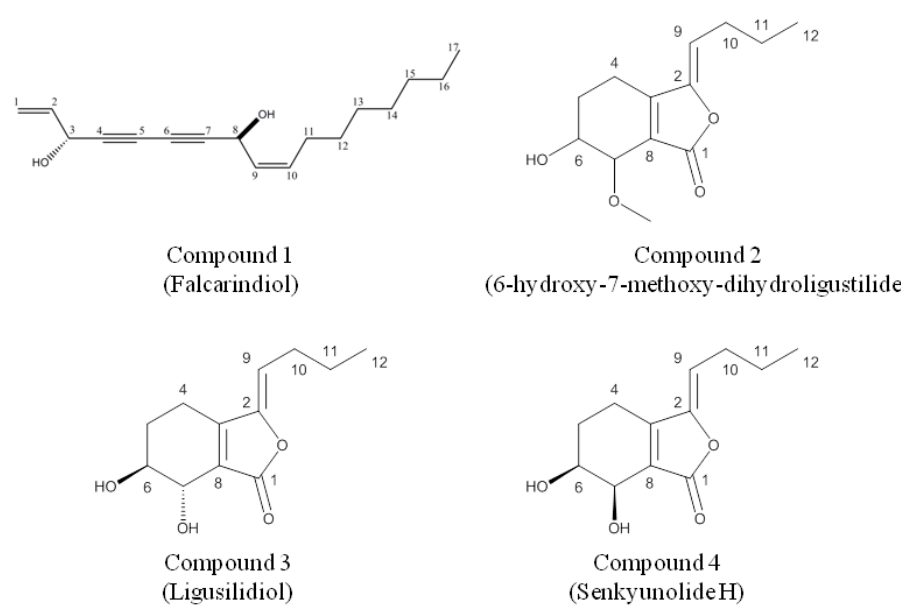
Figure 1. Chemical structures of isolated